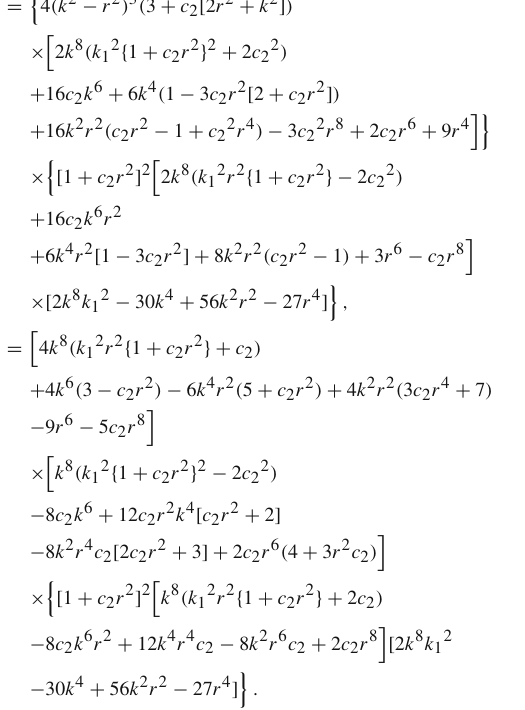
Fig. 14 Plot of the adiabatic index versus the radius r using the con- stants constrained from PSR J 1614-2230 (cid:29) (cid:21) r = 4 ( k 2 − r 2 ) 3 ( 3 + c 2 [ 2 r 2 + k 2 ]